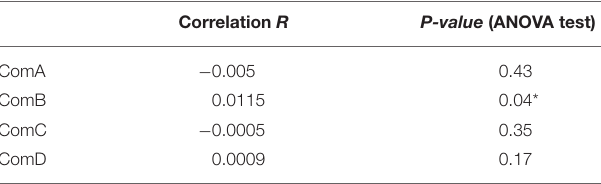
TABLE 7 | Correlation coefficient R and ANOVA test between relatedness coefficient and HWI pairwise within-community. Correlation